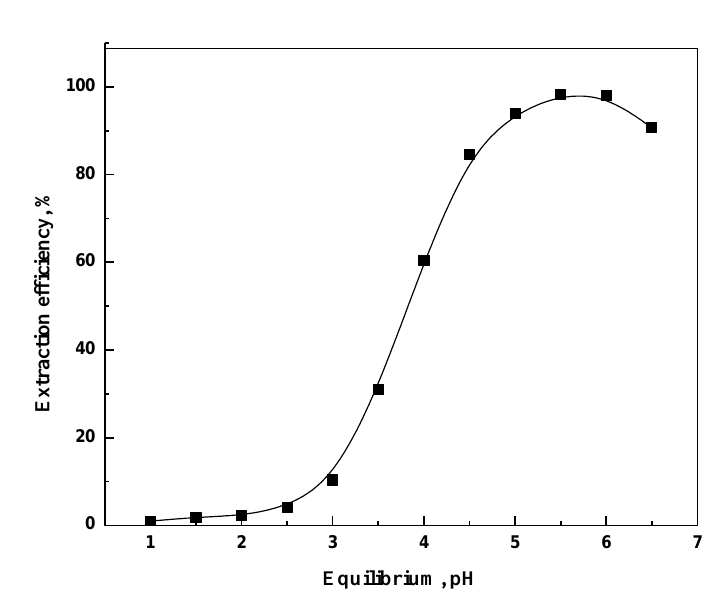
Fig. 1. Effect of pH on the extraction of copper, Conditions: 15% (v/v) furfuryl thioalcohol in kerosene, O/A=1, Na 2 SO 4 = 0.5 mol L -1 , equilibrium time 10 minutes.